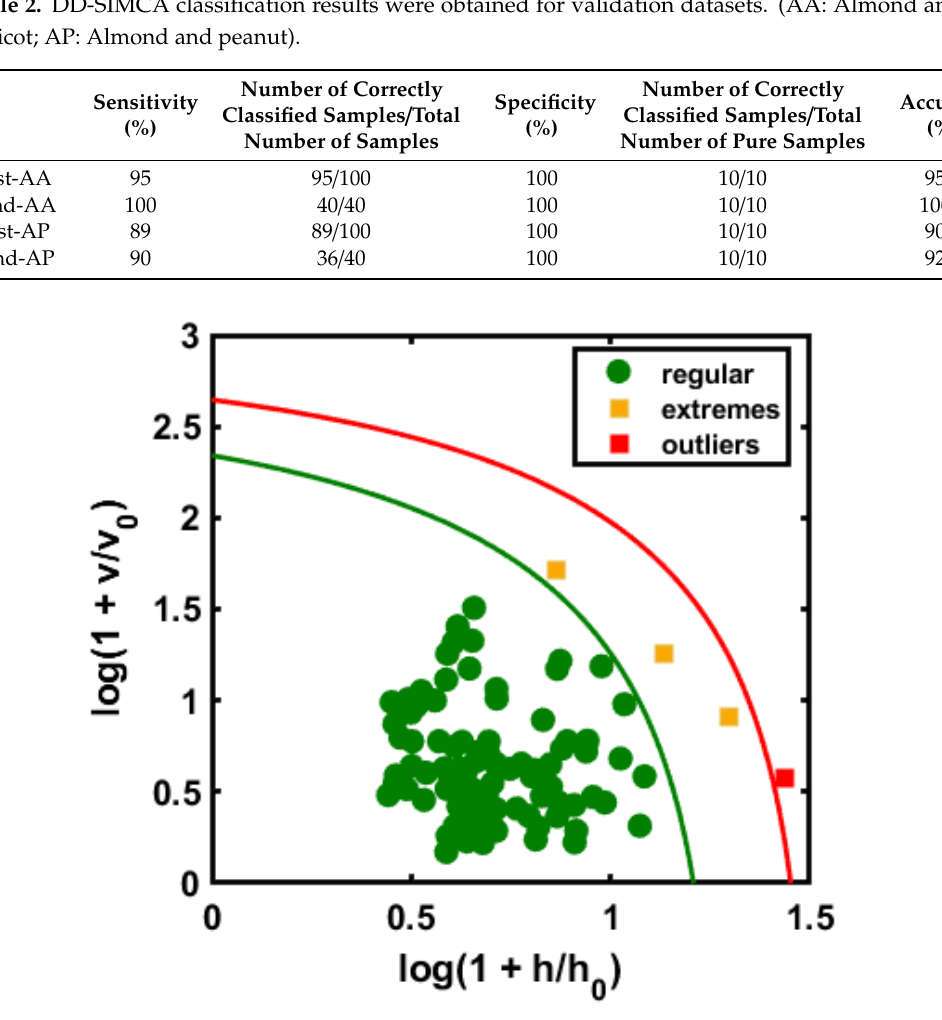
Figure 5. Chi-square acceptance area of DD-SIMCA for the target class.